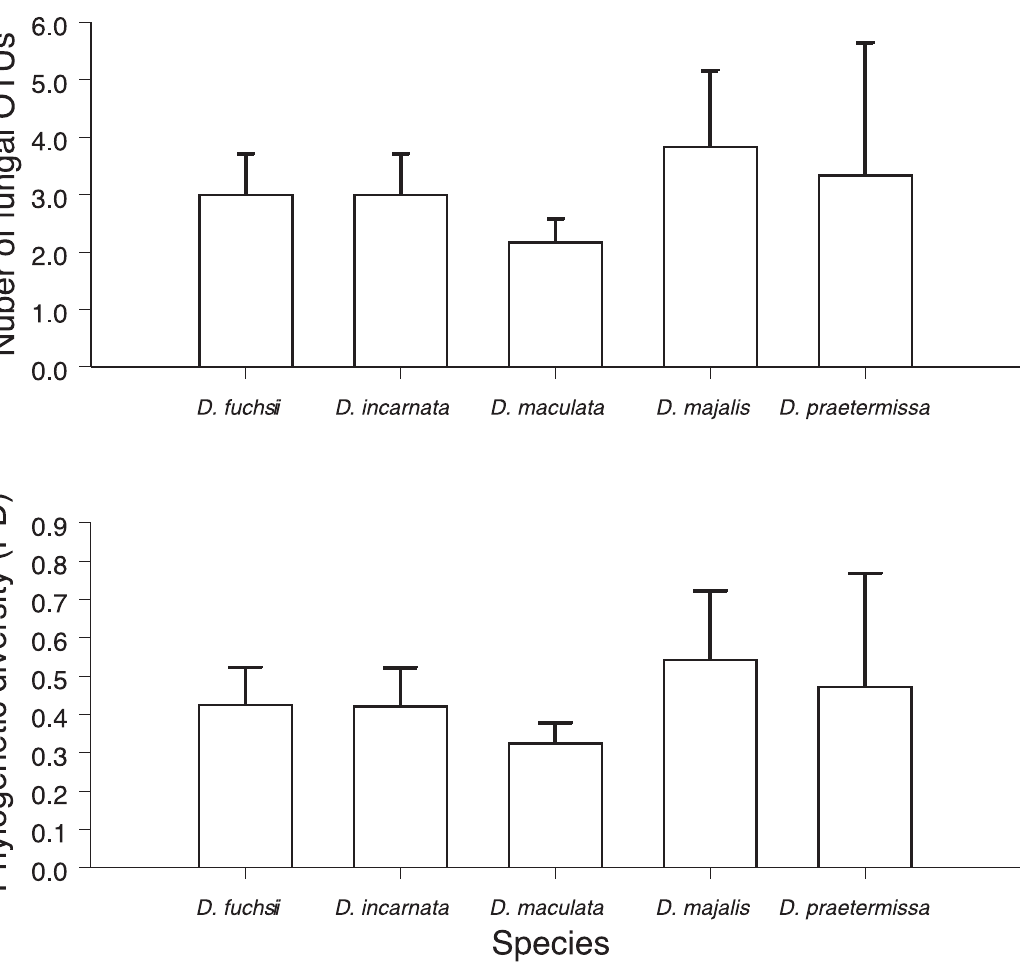
Figure 3. Number of fungal operational taxonomic units (OTUs) per population and phylogenetic diversity (PD) corrected for species richness in five Dactylorhiza species.